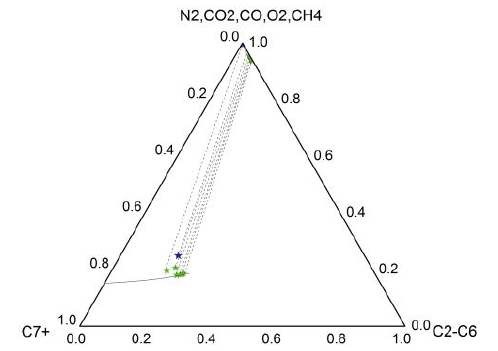
Figure 6—Ternary phase diagram after multiple contact of air and crude oil.